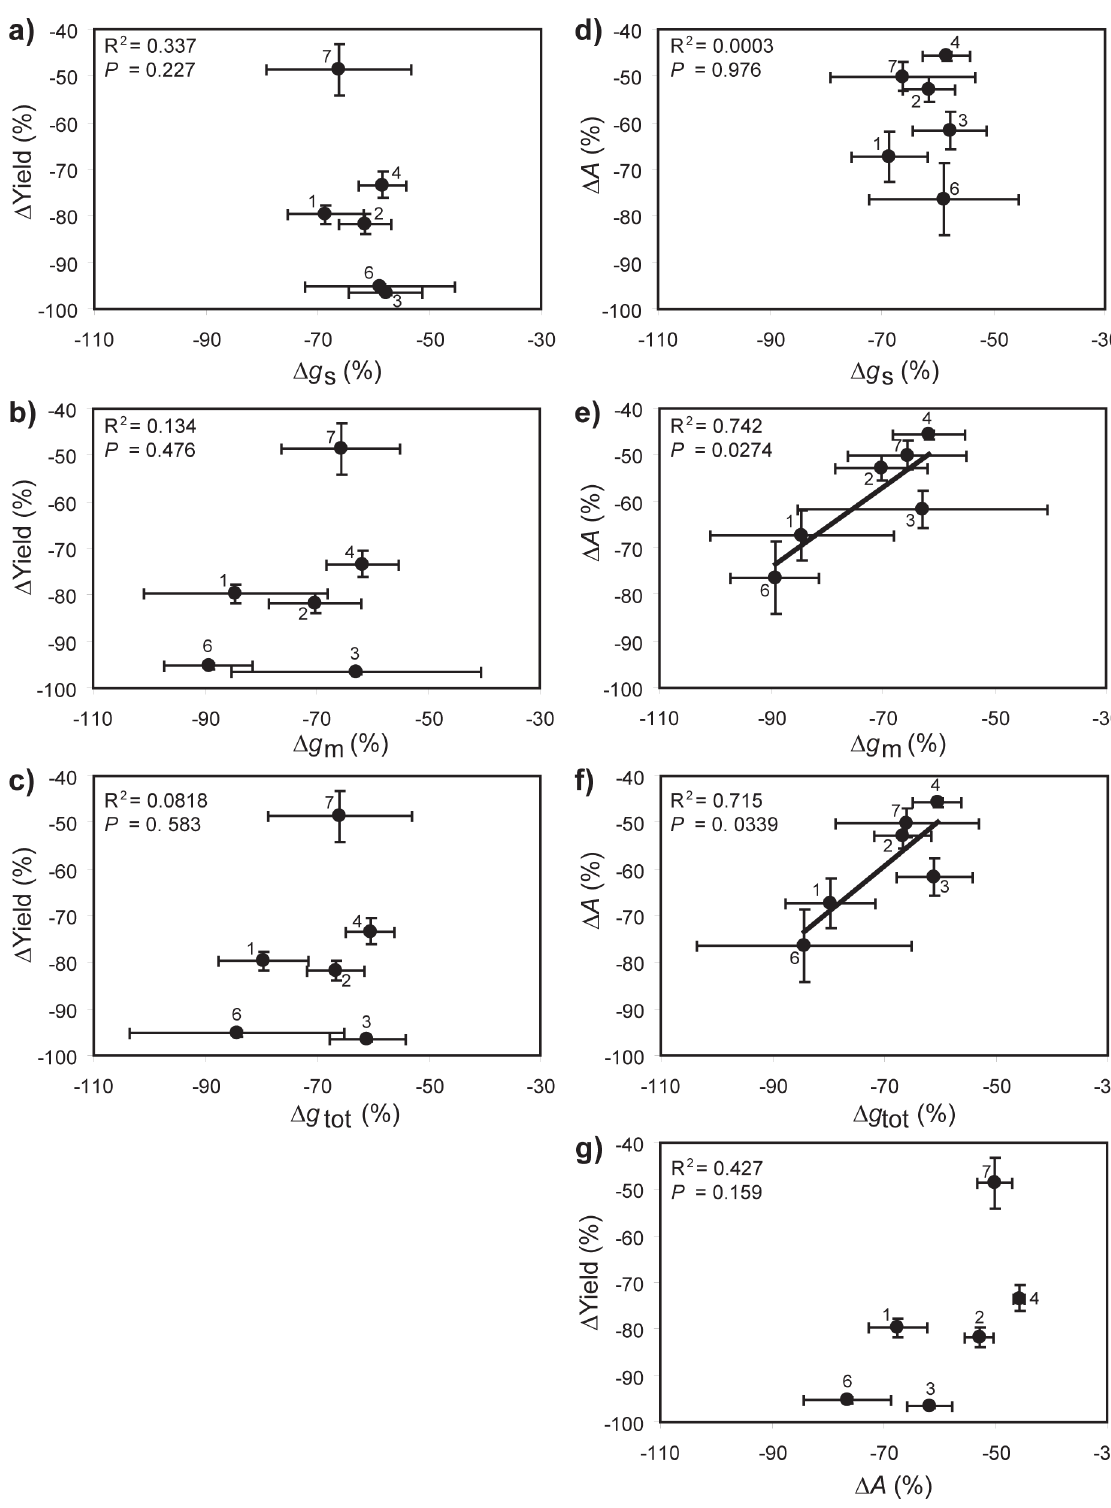
Figure 6. Changes in yield and photosynthesis in relation to modification of diffusive resistances to CO 2 uptake following water- stress. Those varieties that experienced smaller reductions in parameters were more tolerant of drought. a) relationship between D yield and D g s (linear regression: R 2 =0.337; F 1,4 =2.032; P =0.227); b) relationship between D yield and D g m (linear regression: R 2 =0.134; F 1,4 =0.618; P =0.476); c) relationship between D yield and D g tot (linear regression: R 2 =0.0818; F 1,4 =0.356; P =0.583); d) relationship between D A and D g s (linear regression: R 2 =0.0003; F 1,4 =0.00106; P =0.976); e) relationship between D A and D g m (linear regression: R 2 =0.742; F 1,4 =11.527; P =0.0274); f) relationship between D A and D g tot (linear regression: R 2 =0.715; F 1,4 =10.042; P =0.0339), and; g) relationship between D yield and D A (linear regression: R 2 =0.427; F 1,4 =2.979; P =0.159). Error bars as in Figure 1. Numbers next to data points indicate Oryza sativa variety as in Figure 1. doi:10.1371/journal.pone.0109054.g006 PLOS ONE | www.plosone.org